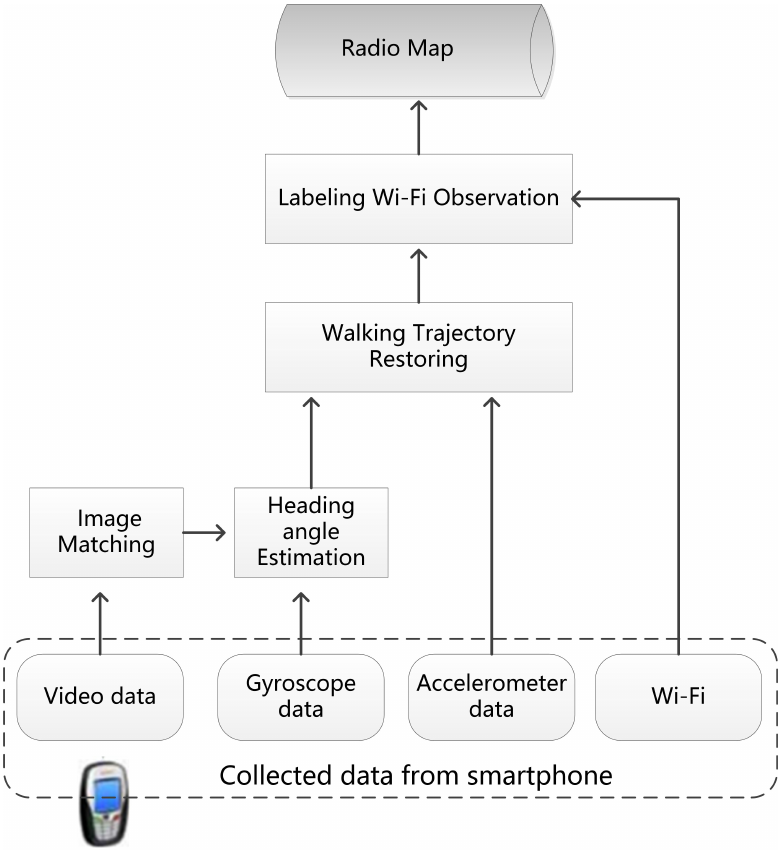
Figure 1. The overview of this proposed